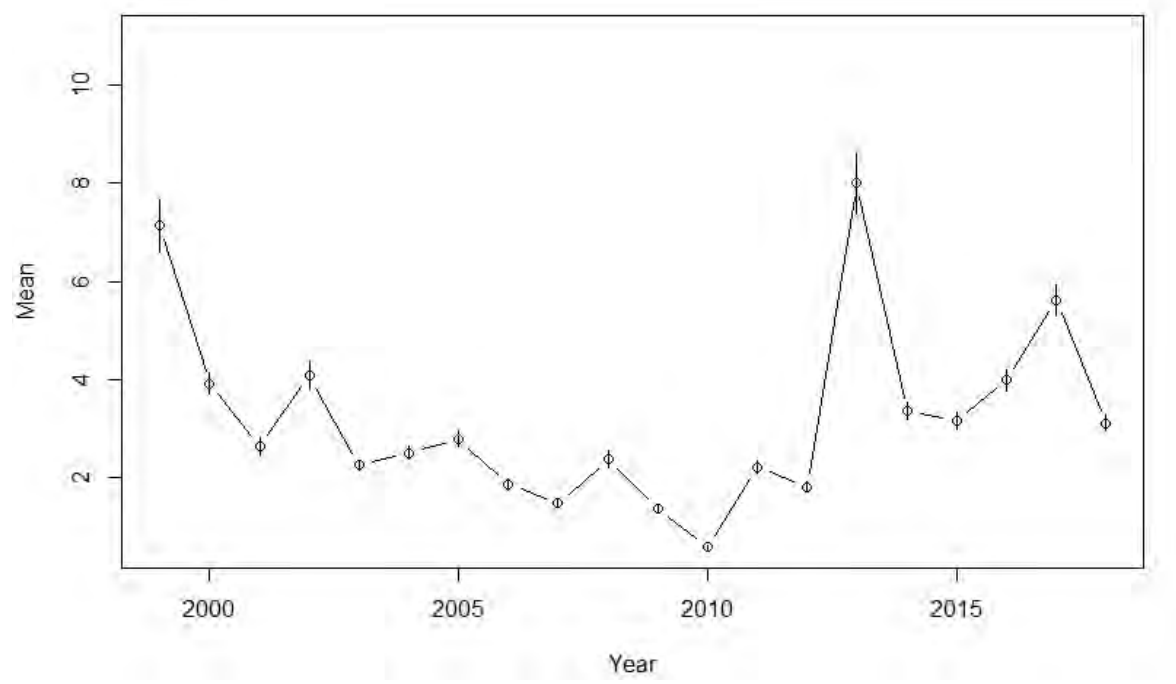
Figure 45. Abundance index for adult female horseshoe crabs (>= 19 cm pw) in the spring (April and August) from New Jersey’s Ocean Trawl Survey.